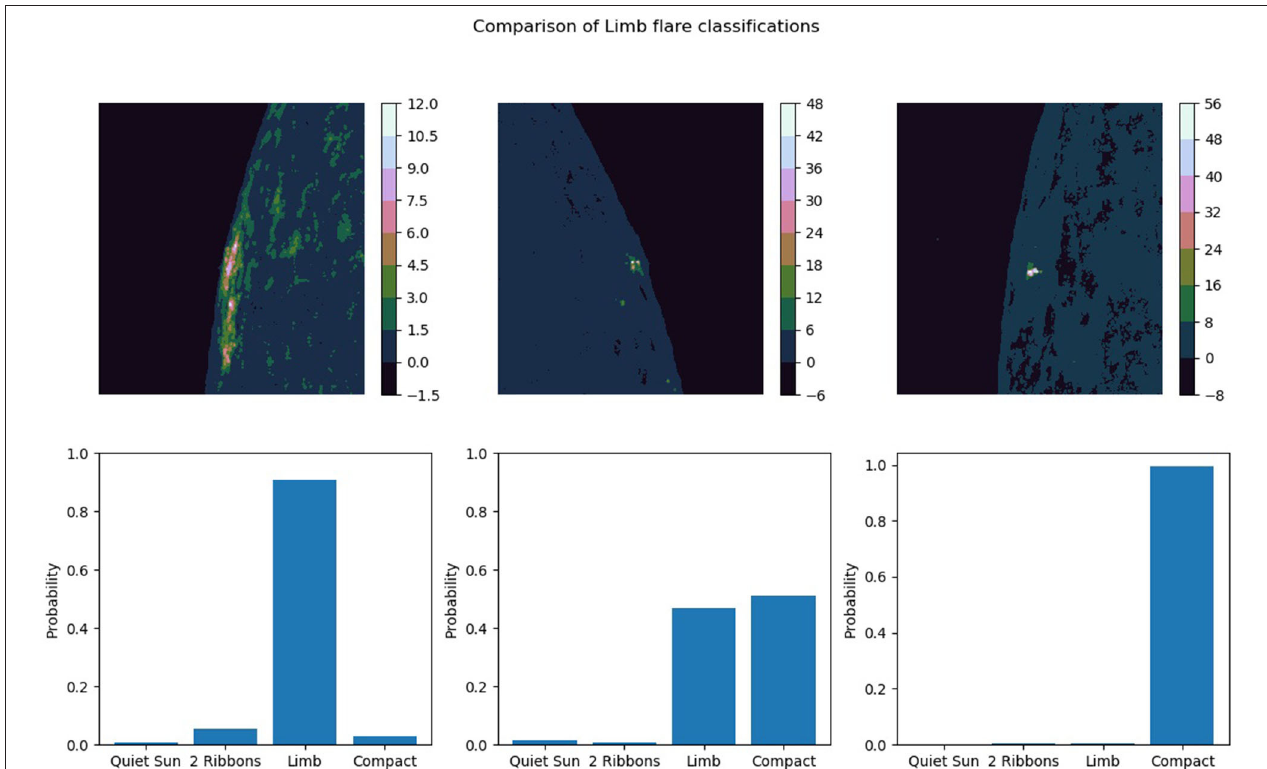
FIGURE 3 | Model output on previously unseen images in the test set. All of the data should belong to the limb flare class, however confusion is seen between limb flares and compact